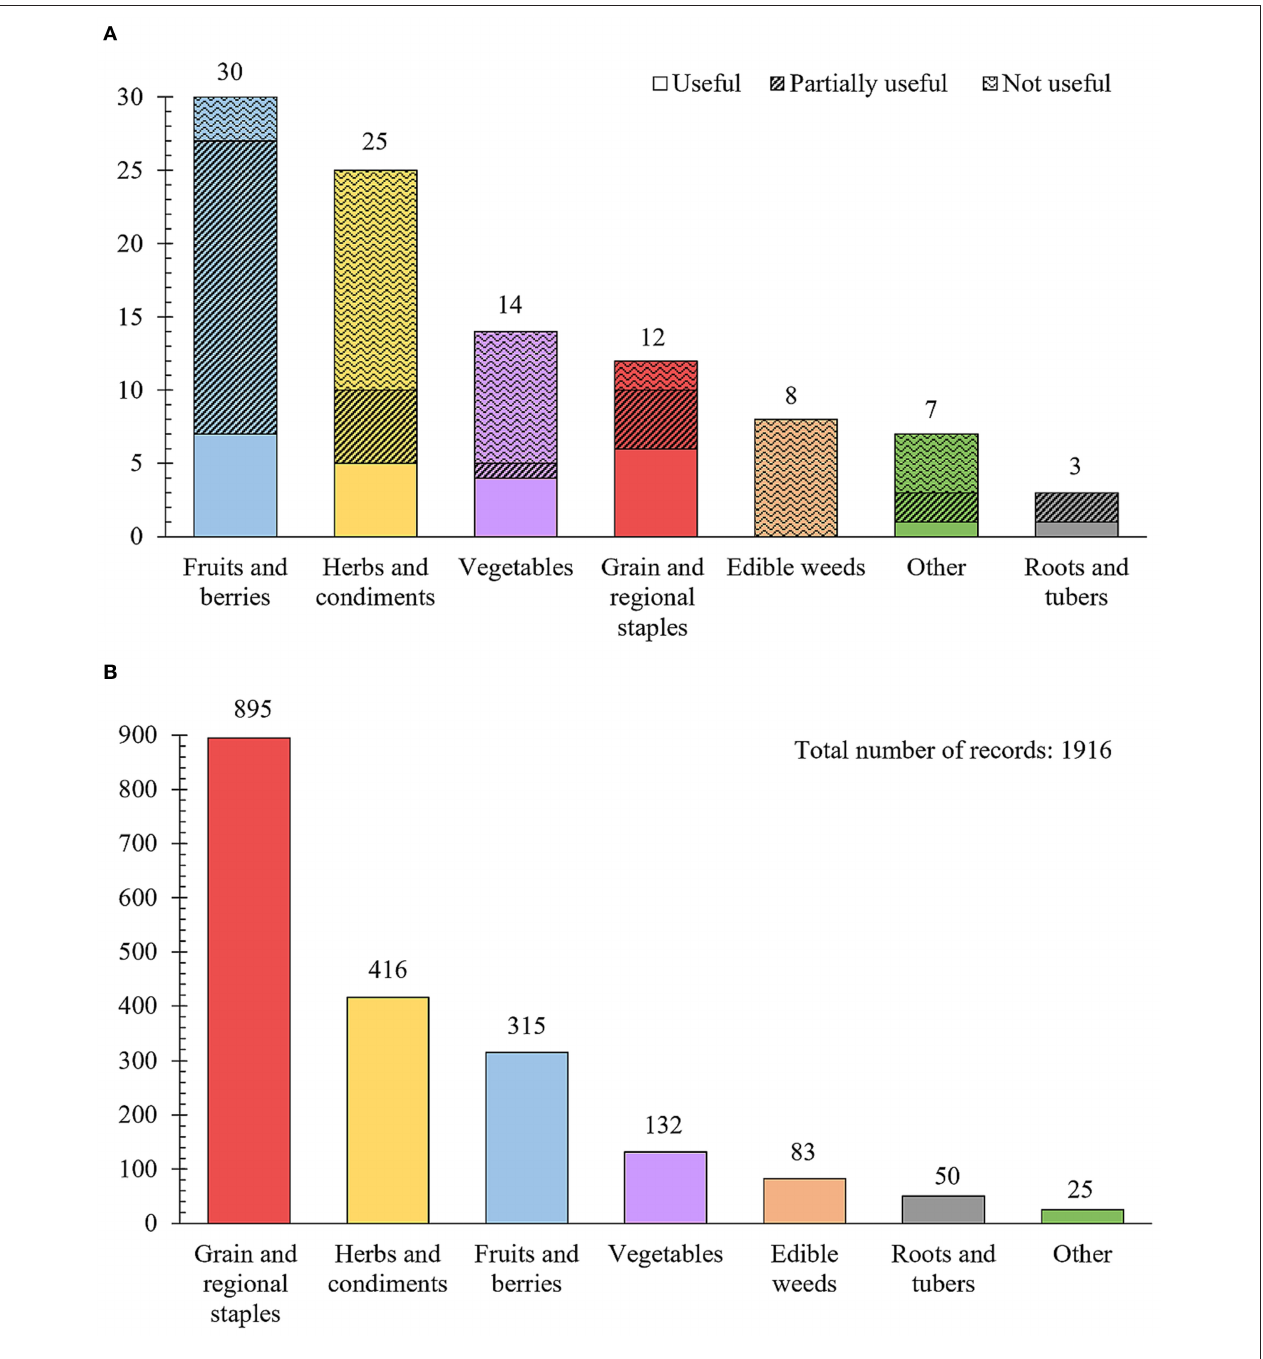
FIGURE 5 | (A) Usefulness of all documented plant species as propagation material. (B) Categories of edible plant species and variants from local merchants in 10 rural markets in the Huasteca Potosina. Note that the categories and grain and regional staples also include species like Sechium edule and Nopalea cochenillifera .